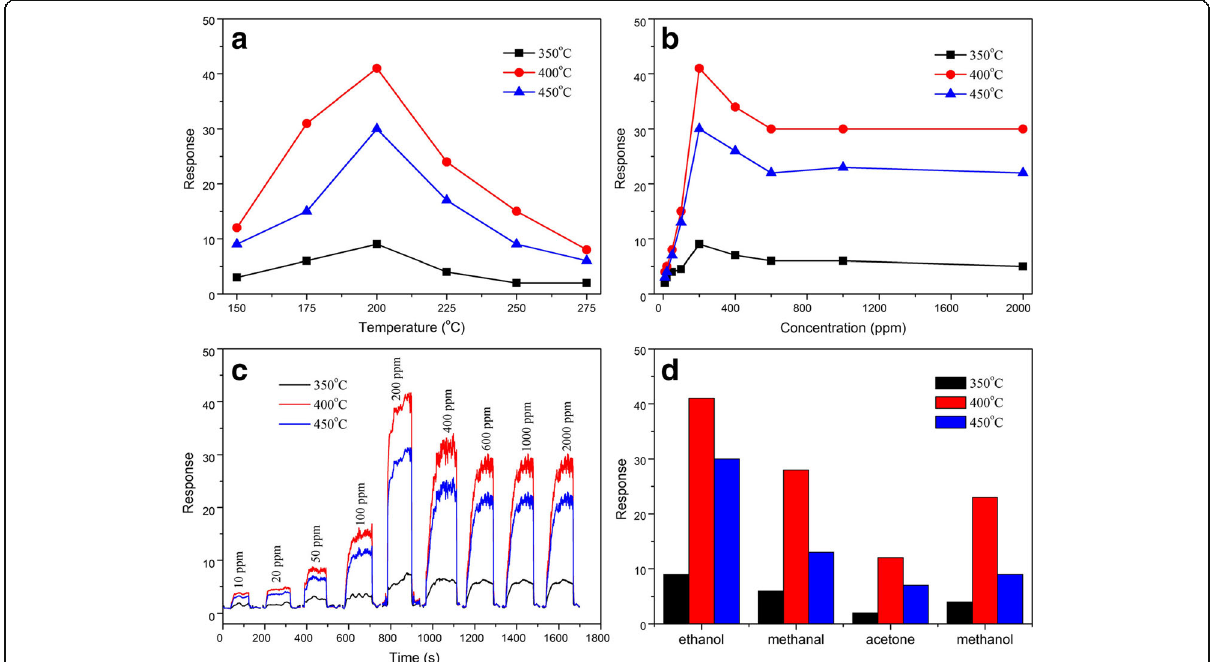
Fig. 6 a Responses of the mesoporous SnO 2 sensors to 200 ppm ethanol at different operating temperatures, b responses vs. ethanol concentration, and c response-recovery curve for the mesoporous SnO 2 sensors (the operating temperature is 200 °C). d Gas responses of the mesoporous SnO 2 sensors to 200 ppm of ethanol, methanal, methanol, and acetone operated at 200